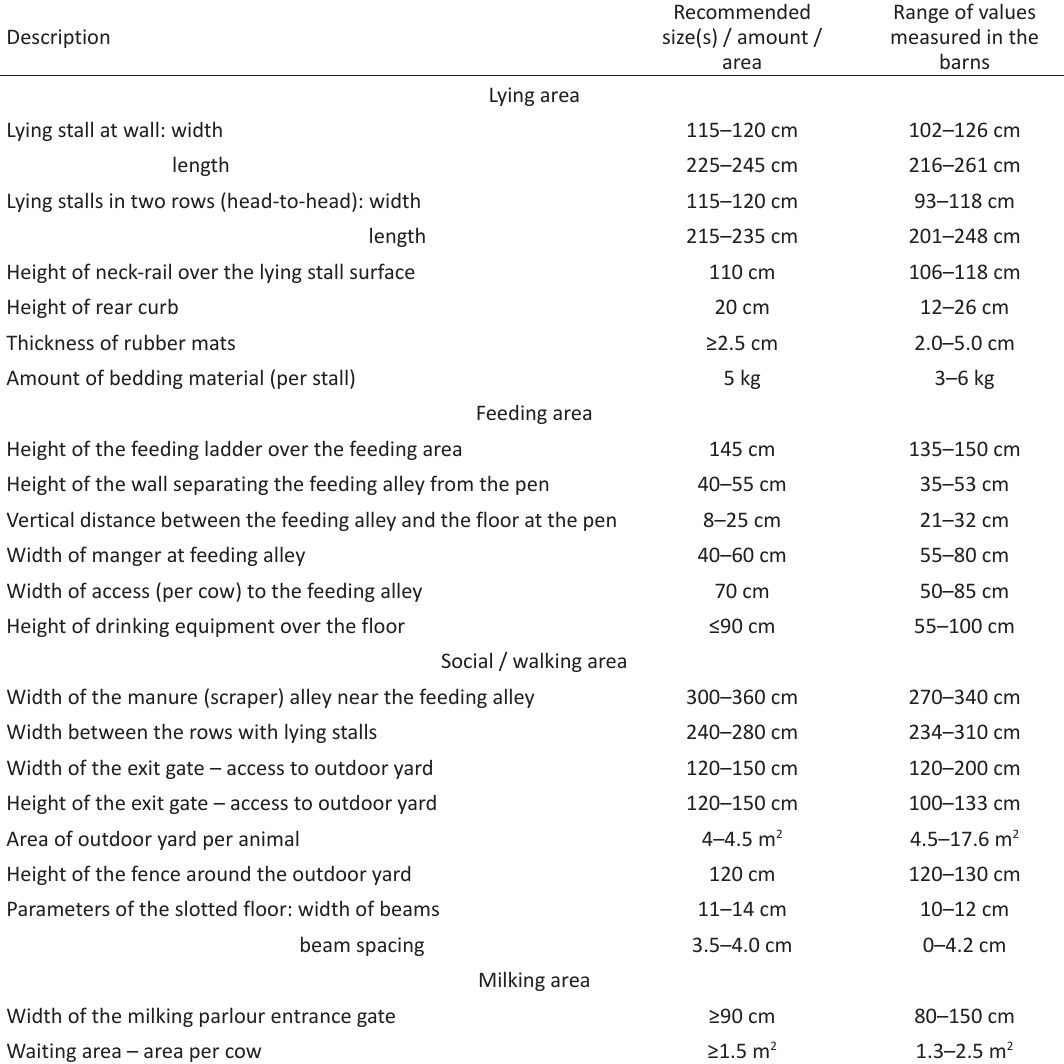
Table 2. Parameters measured in freestall barns in different zones (based on the range of values measured in individual barns) vs. recommended parameters (reference values) in Poland